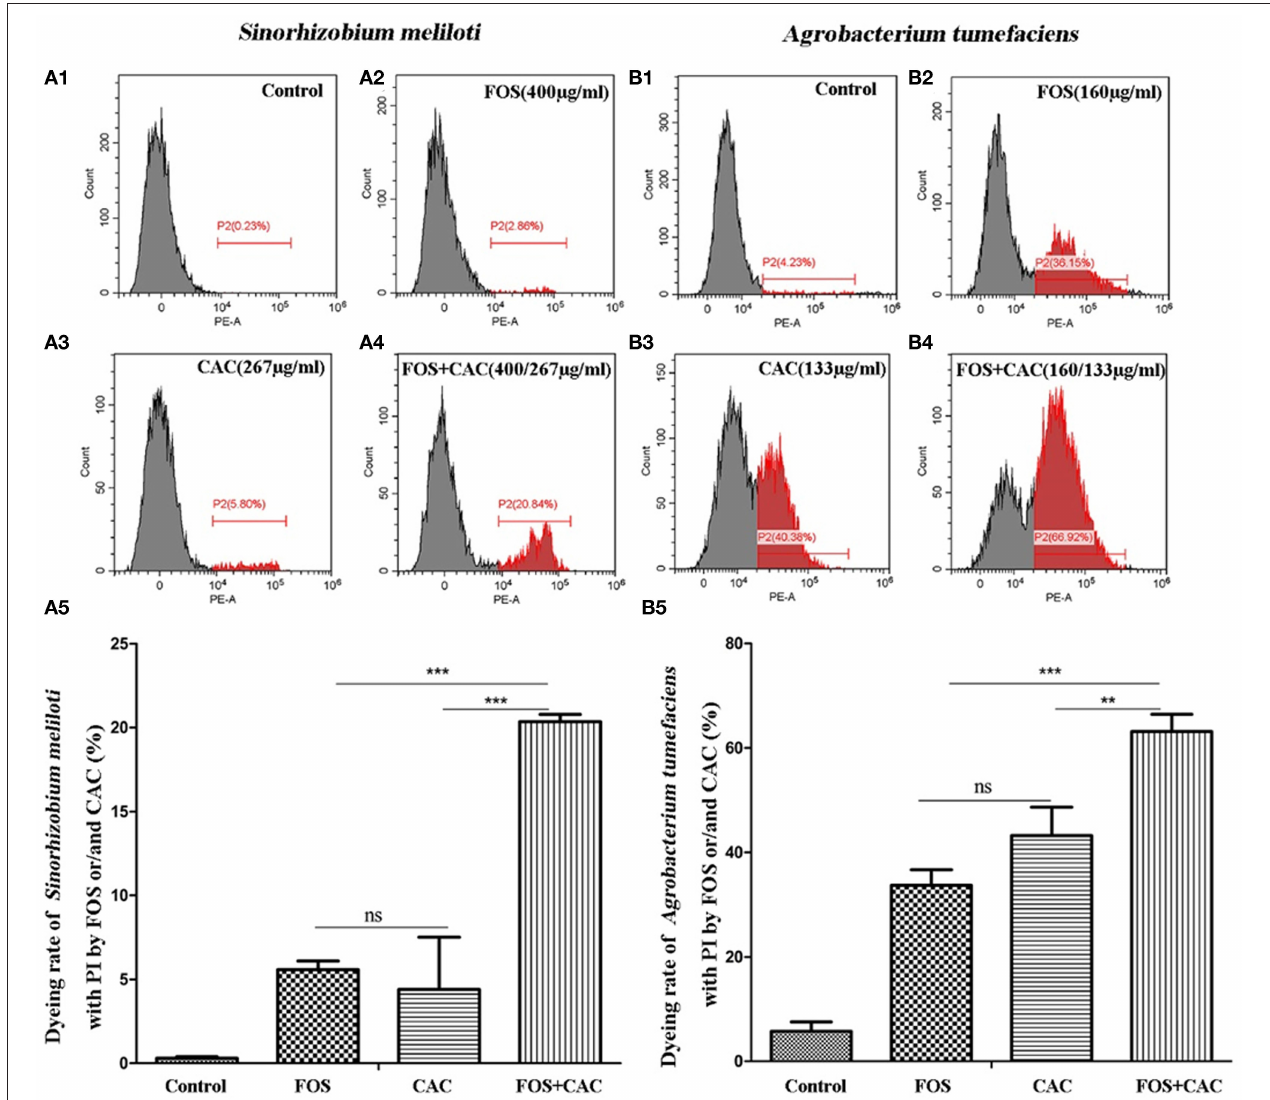
FIGURE 5 | Flow cytometry to determine cell membrane permeability of FOS or/and CAC on Sinorhizobium meliloti and Agrobacterium tumefaciens. (A) Changes of cell membrane permeability of Sinorhizobium meliloti with FOS and/or CAC treatment. A1: control; A2: FOS (400 µ g/mL); A3: CAC (267 µ g/mL); A4: FOS (400 µ g/mL) + CAC (267 µ g/mL); A5: a statistical chart of A1, A2, A3, A4. (B) Changes of cell membrane permeability of Agrobacterium tumefaciens with FOS and/or CAC treatment. B1: control; B2: FOS (160 µ g/mL); B3: CAC (133 µ g/mL); B4: FOS (160 µ g/mL) + CAC (133 µ g/mL); B5: a statistical chart of B1, B2, B3, B4.